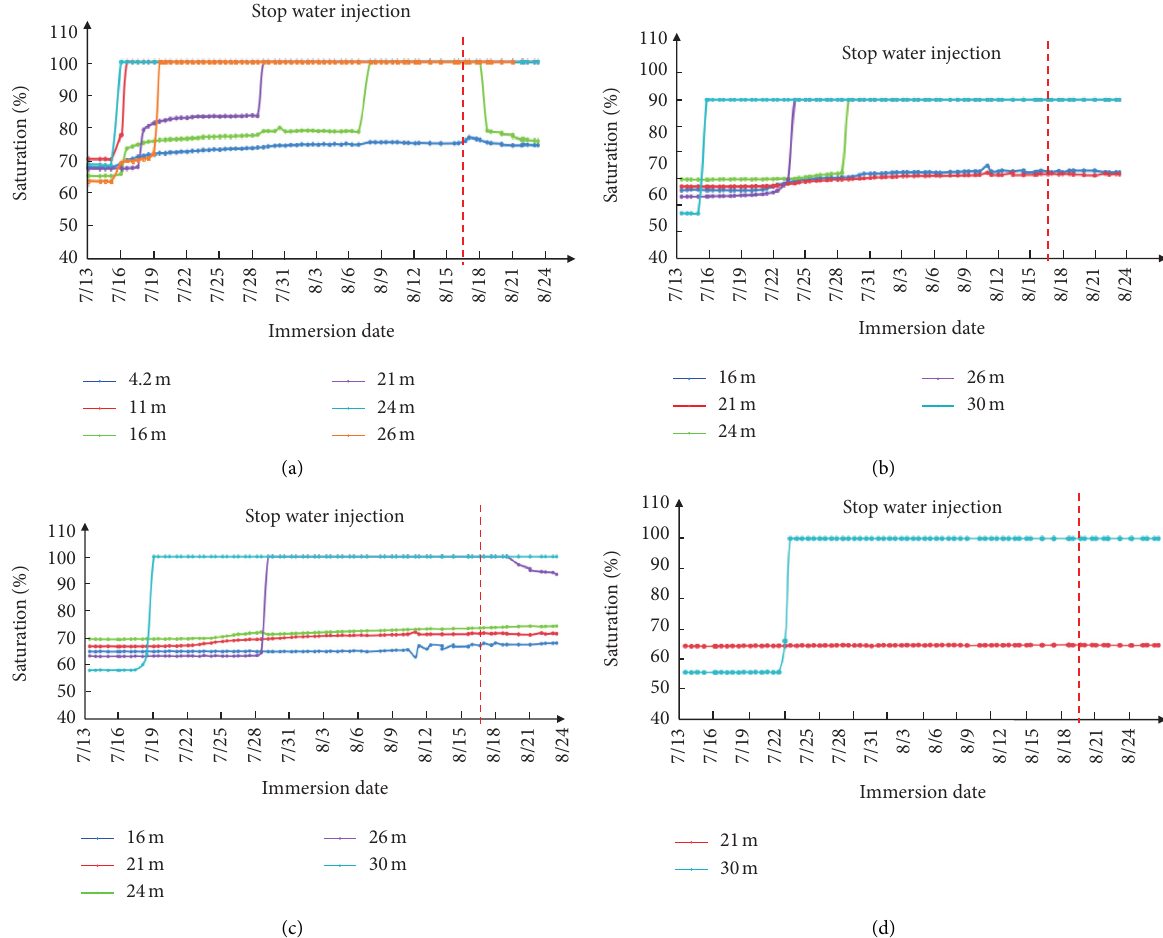
Figure 6: The soil saturation curve with immersion time: (a) exploratory well T1, (b) exploratory well T2, (c) exploratory well T3, and (d) exploratory well T5.